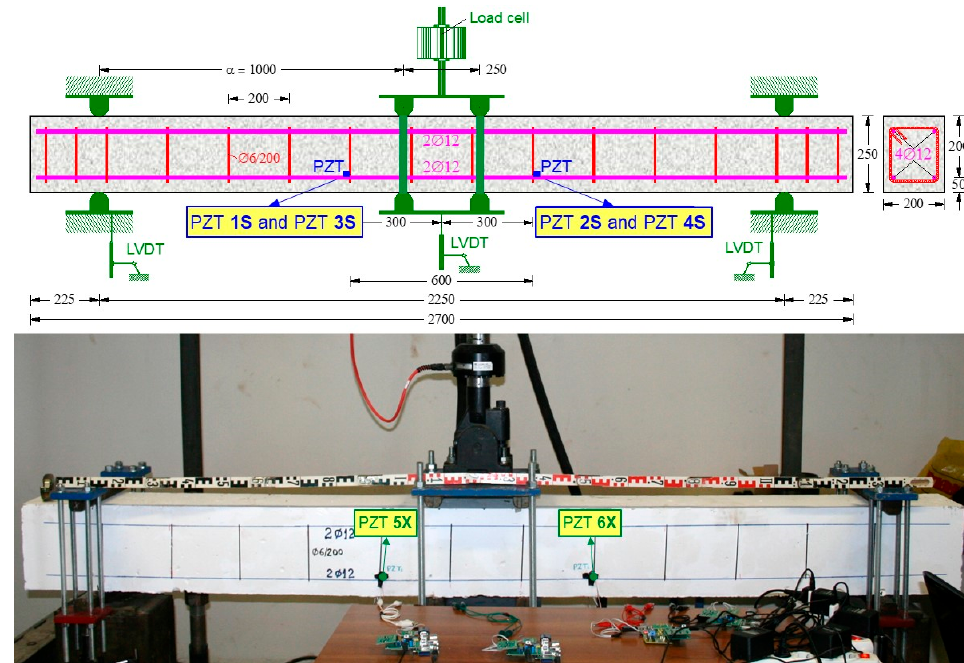
Figure 3. Characteristics of the tested RC FLC beam under cyclic loading.